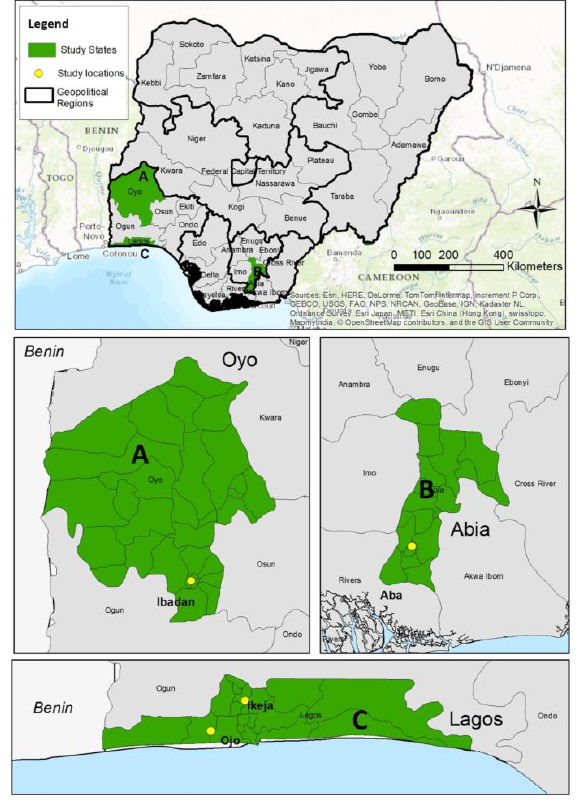
Figure 1. Map of Nigeria showing the study locations [28].